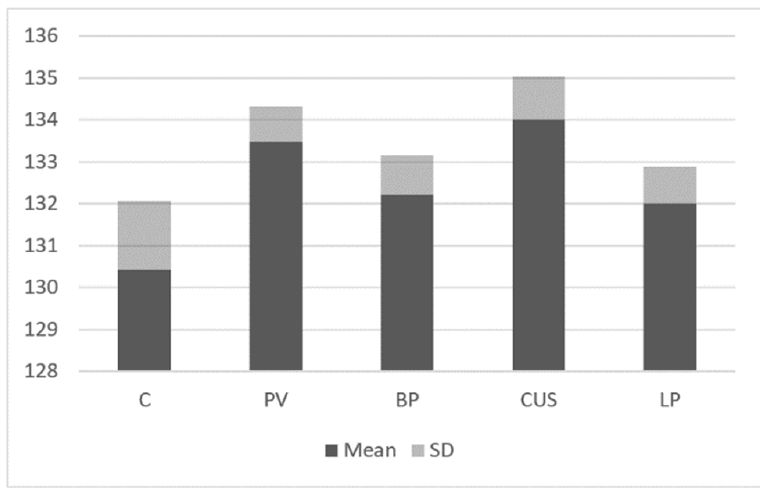
Figure 4. Immunoblotting. JAK3 expression in study groups and control group. The expression of STAT2 was evaluated higher in CUS patients (145.83 ± 0.25) and LP patients (143.85 ± 3.09) as compared to the control group (136.28 ± 2.84; p < 0.05). There was no significant difference between STAT2 expression in PV and BP patients vs. the control group (Figure 5).